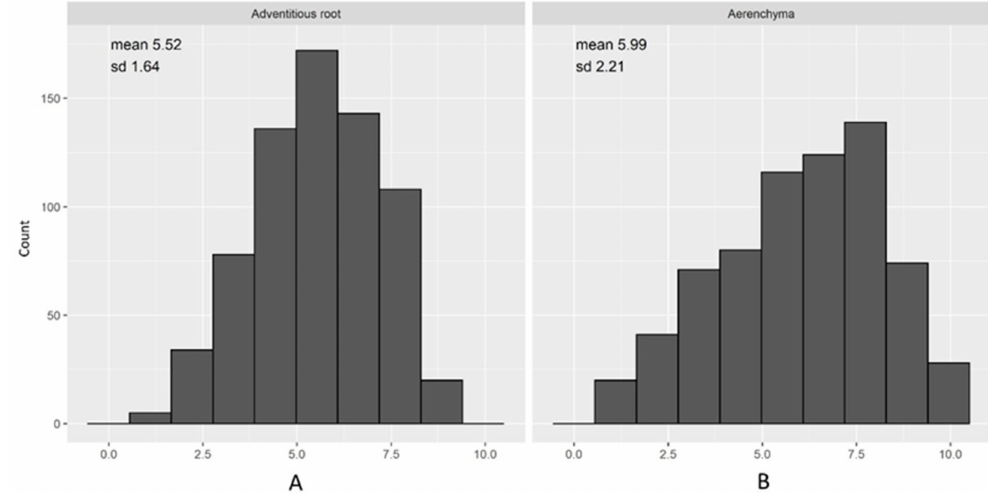
Figure 2. Frequency distribution of adventitious root development ( A ) and aerenchyma formation scores ( B ). The numbers are averages over all trials. A lower score means more